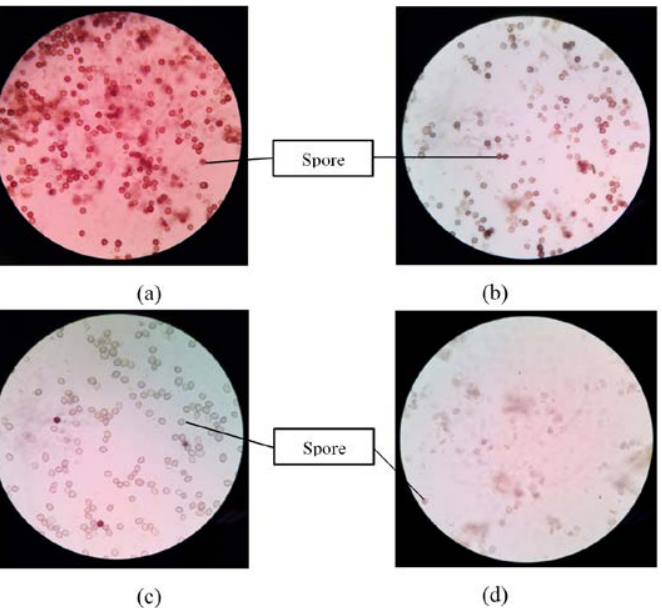
Fig. 1 . Morphological structure of (a) live cells of A.niger , (b) dead cells of A . nige r, (c) live cells of R. oryzae and (d) dead cells of R.oryzae under 400x magnification of light microscope